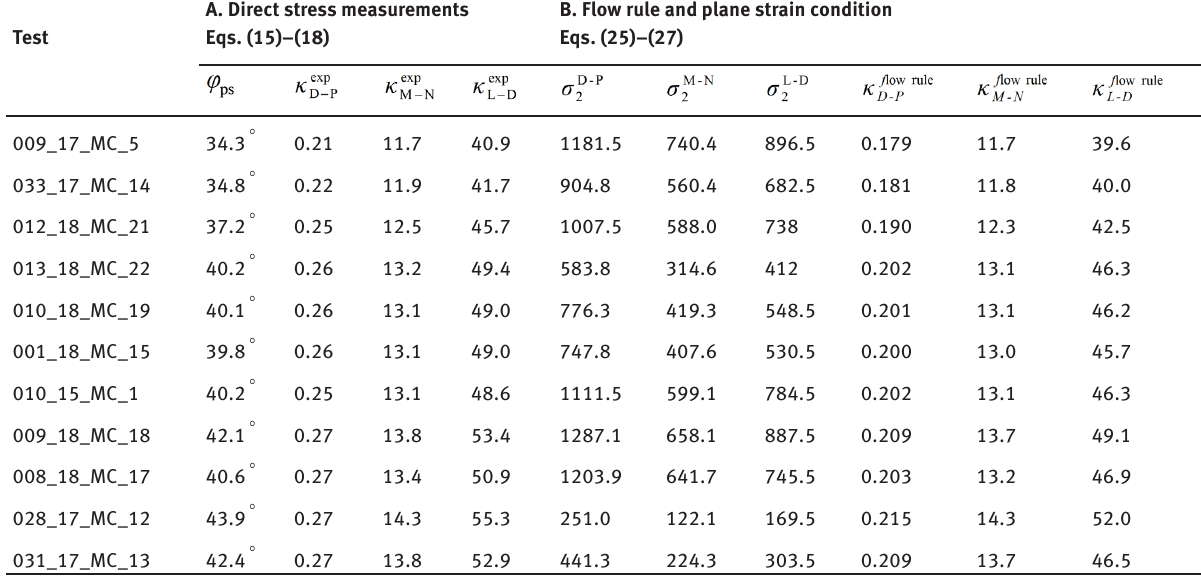
Table 4: Characteristic parameters of Drucker–Prager, Matsuoka–Nakai and Lade–Duncan soil failure criteria, obtained from direct stress measurements (A) and the associated flow rule assuming plane strain conditions